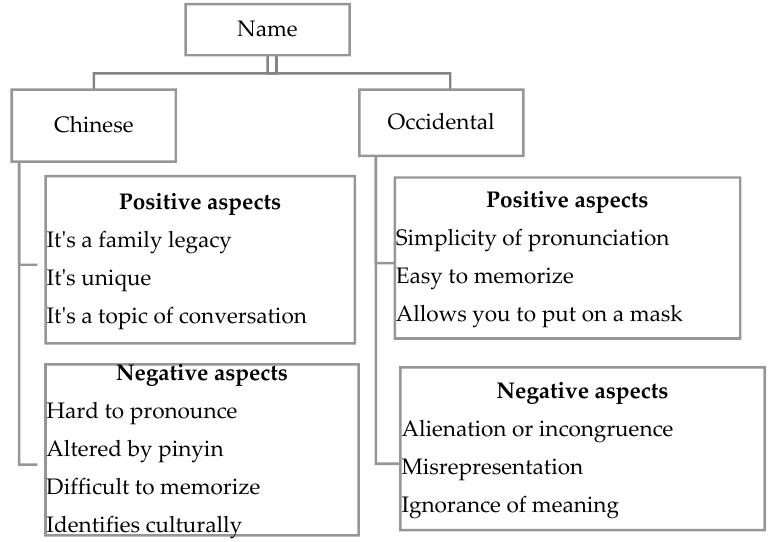
Figure 4. Reactions to the use of Western and Chinese names (from Liao 2011, pp. 92–103).